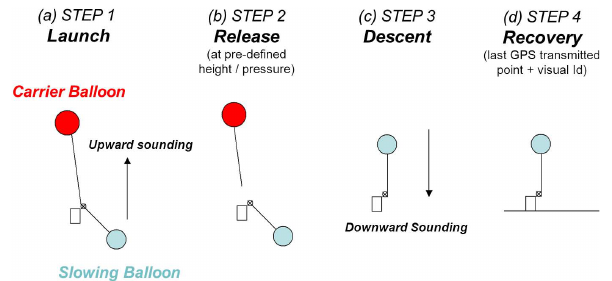
Fig. 1. Principle of the dual-balloon sounding.